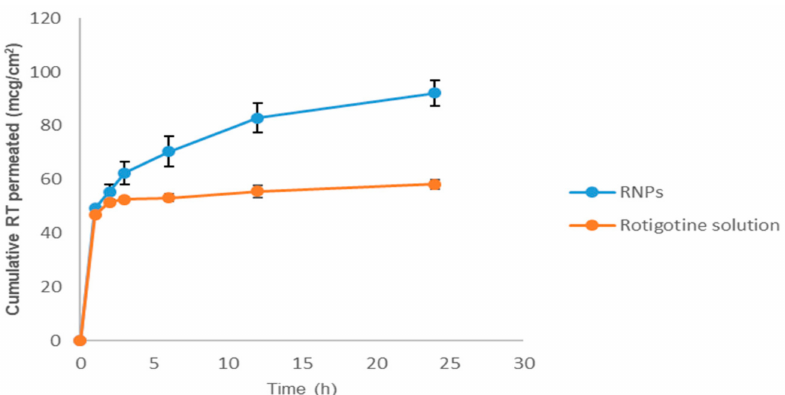
Figure 12. Ex vivo nasal permeation studies of rotigotine solution and rotigotine-loaded chitosan nanoparticles in PBS at pH 7.4 ( n = 3).